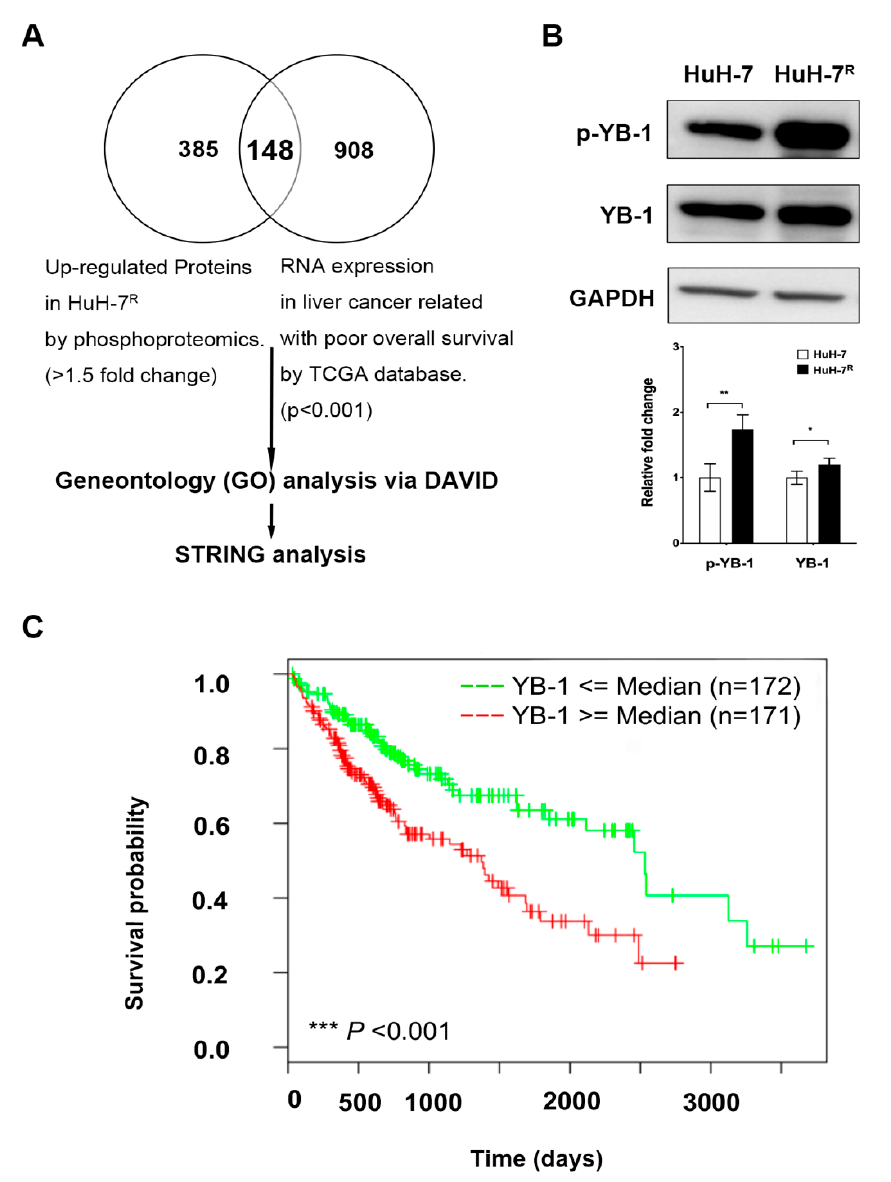
Figure 1. Bioinformatic identification and validation of Y-box binding protein-1 (YB-1) as a potential biomarker in HuH-7 R cells. ( A ) Strategy for identification of sorafenib resistance-related differentially expressed molecules in hepatocellular carcinoma (HCC). ( B ) Phosphorylation levels of YB-1 and total YB-1 expression in HuH-7 and HuH-7 R cells validated by immunoblotting, upper panel. Relative changes of the expression levels were quantified using GAPDH as normalization control, lower panel. (* p < 0.05; ** p < 0.01). ( C) Kaplan-Meir OS curves of the YB-1 gene among 343 HCC patients in the TCGA dataset. The p value was calculated with the log-rank test (*** p < 0.001).